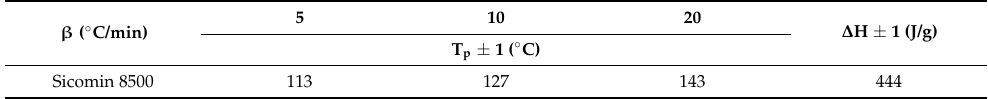
Table 3. Curing peak temperatures and enthalpy of the epoxy